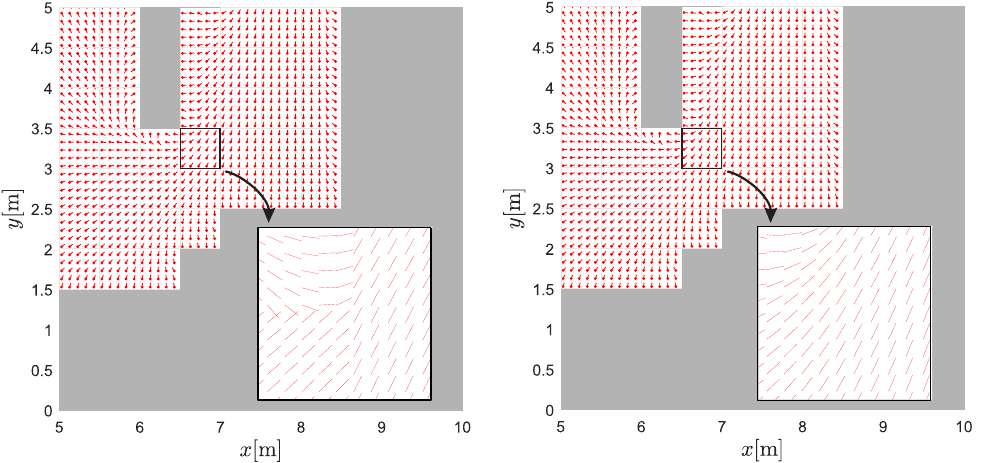
Figure 3. Comparison of the negative gradient field for the lower part of the environment in Figure 1. The gradient of the interpolated potential field may have discontinuities ( left ), while the additional interpolated gradient has smooth transitions ( right